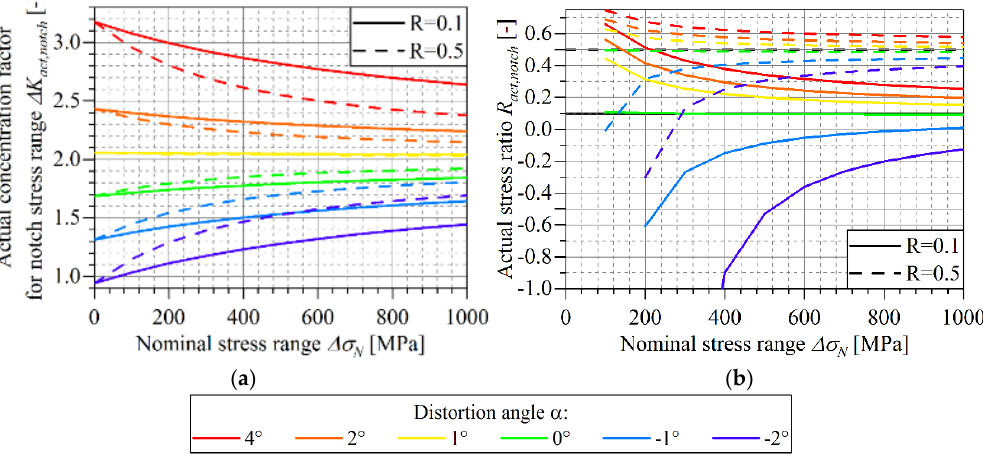
Figure 18. Course of actual values with nominal stress range. ( a ) Effective notch stress range; ( b ) Stress ratio. ( b ) Stress